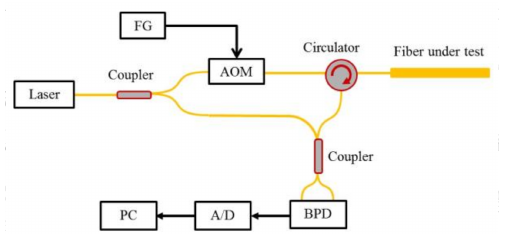
Figure 13. Experimental setup of the time-gated digital OFDR system. FG is function generator. AOM is acousto-optic modulator. BPD is balanced photo detector. A/D is analog-to-digital convertor. PC is personal computer (reprinted from Liu et al. [17] with permission of OSA; copyright (2015)).